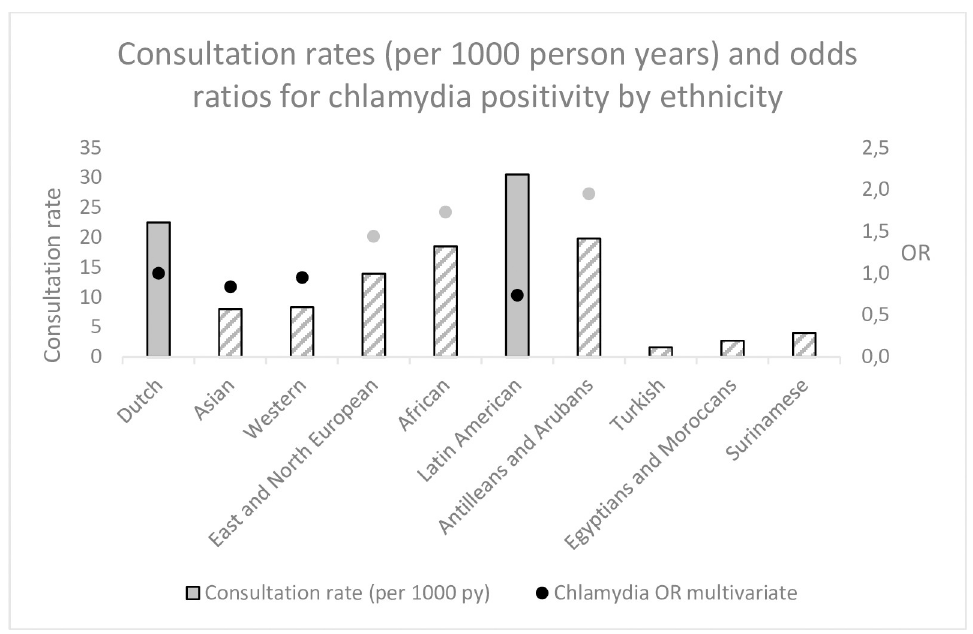
Fig 1. Consultation rates and chlamydia odds ratios from multivariable analysis by ethnicity. Consultation rates significantly lower or equal to Dutch rates are striped and chlamydia OR significantly higher than Dutch is coloured grey. For significance see Tables 1 and